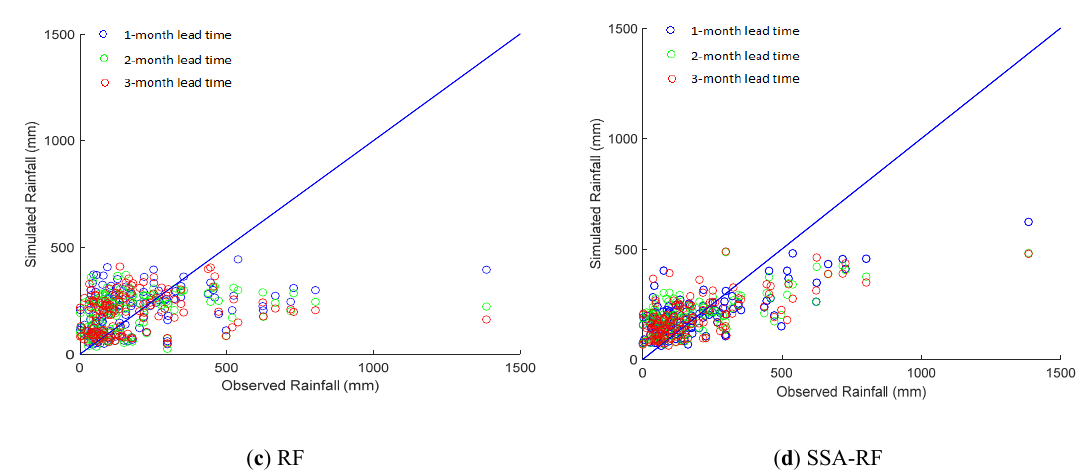
Figure 5. Scatterplots of the observed vs. forecasted rainfalls by the ( a ) LS-SVR, ( b ) SSA-LSSVR, ( c ) RF, and ( d ) SSA-RF models during the validation period for Deji reservoir watershed 1-,2-, and 3-month lead time.